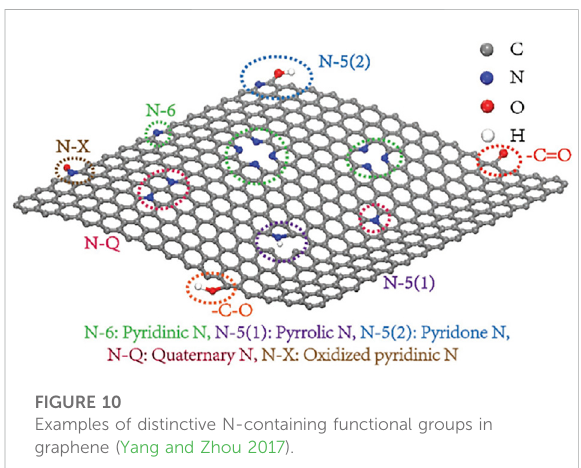
FIGURE 10 Examples of distinctive N-containing functional groups in graphene (Yang and Zhou